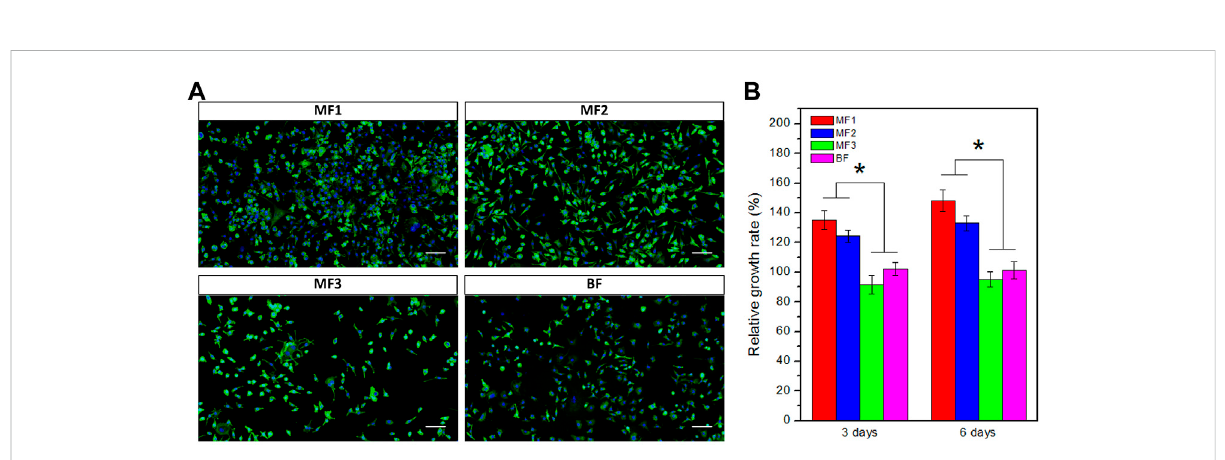
FIGURE 7 Cytocompatibility evaluation. (A) Representative confocal laser scanning microscopy images of L929 cells after 6 days of incubation with different fi lms.CytoskeletonmarkerFITC-PhalloidiningreenandnucleusmarkerDAPIinblue(scalebar:100 μ m). (B) Cellproliferationdatafromthe CCK-8 assay after 3 or 6 days of incubation. * p <